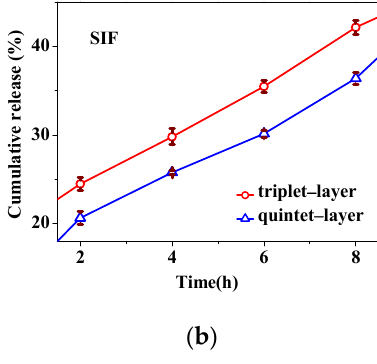
Figure 2. The release profile of protein from nanocapsules in the whole GIT ( a ), the SIF ( b ), and the SCF ( c ). Abbreviations: SGF, simulated gastric fluid; SIF, simulated intestinal fluid; and SCF, simulated colonic fluid.